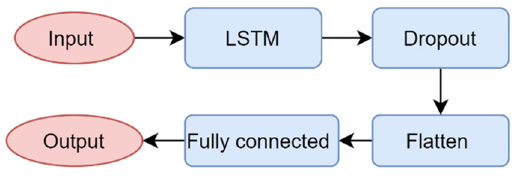
Figure 6: The LSTM structure.